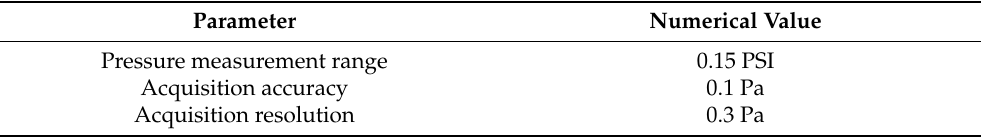
Figure 5. Dynamic pressure and force measuring test equipment. ( a ) Eight − channel pressure sensor module; ( b ) the ATI − 9610 six − component strain gauge balance. Table 1. Technical parameters of the dynamic pressure sensor